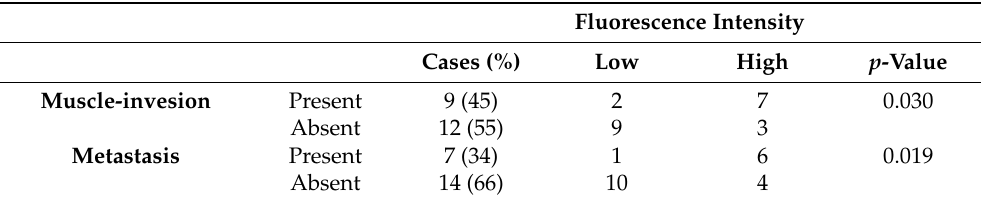
Table 2. Association between fluorescence intensity of 5-ala and clinical condition of urothelial carcinoma